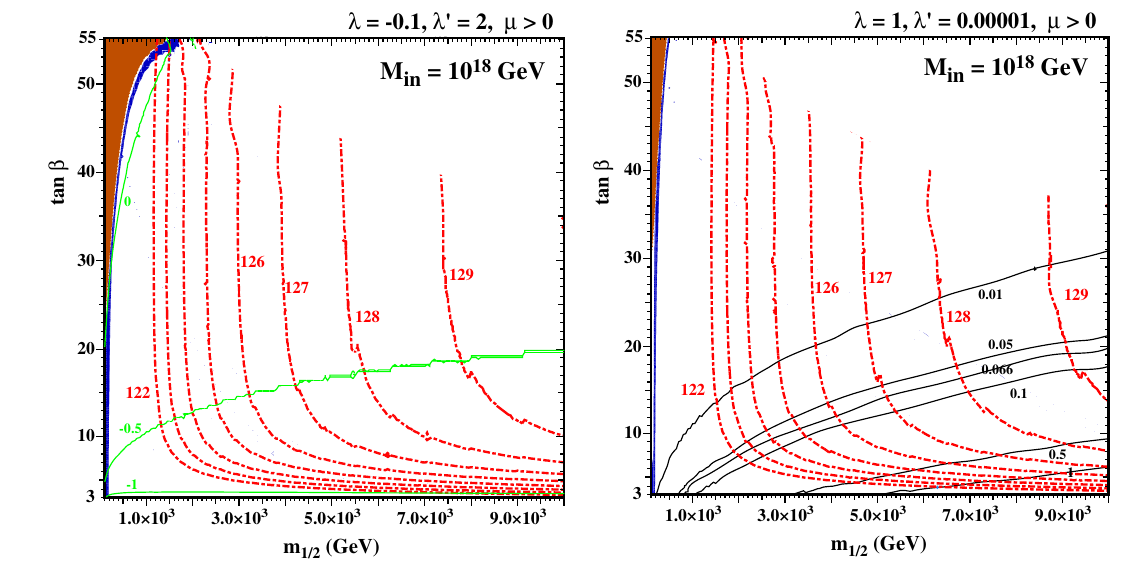
which does not give stable results in the upper right portions of the pan- els . In the left panel , the green curves are contours of c (cid:3) ( m 3 / 2 / m 1 / 2 ) 2 and the proton lifetime is too short throughout. In the right panel , the solid black contours show the proton lifetime in units of 10 35 years, which is acceptably long below the contour labeled 0.066. However, the relic density is too large throughout this